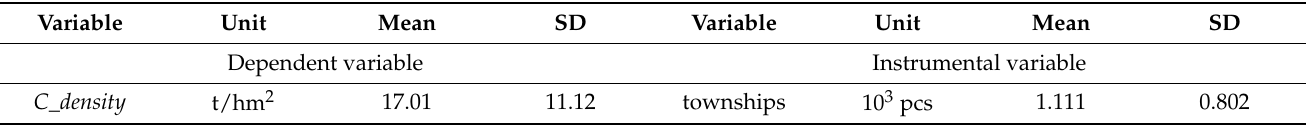
Table 1. Descriptive analysis of key variables (n =